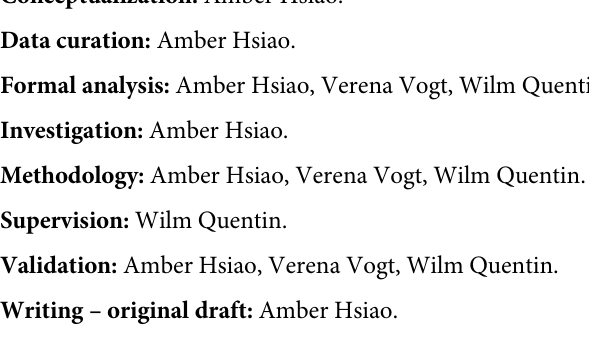
S1 Fig. Country-level residuals for reported difficulty of obtaining care. S2 Fig. Region-level residuals for reported difficulty of obtaining